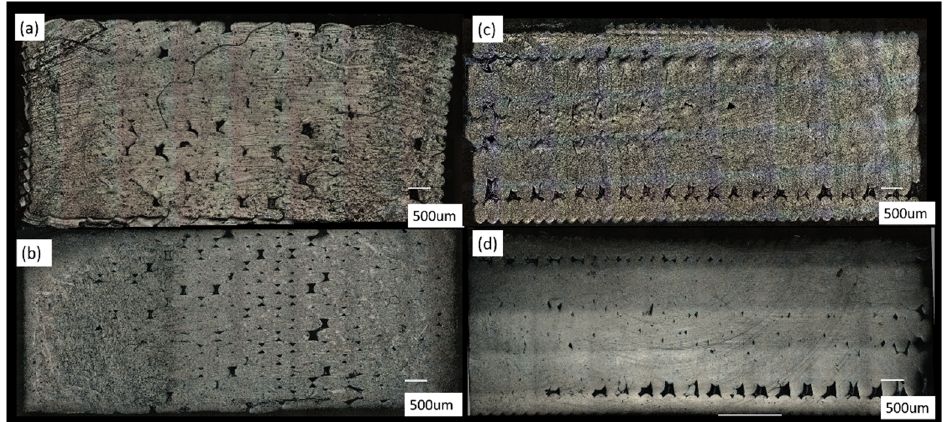
Figure 14. Mesostructure for ( a ) Coupon 9 , ( b ) Coupon XY2 , ( c) Coupon 7 , and ( d ) Coupon ZX1.